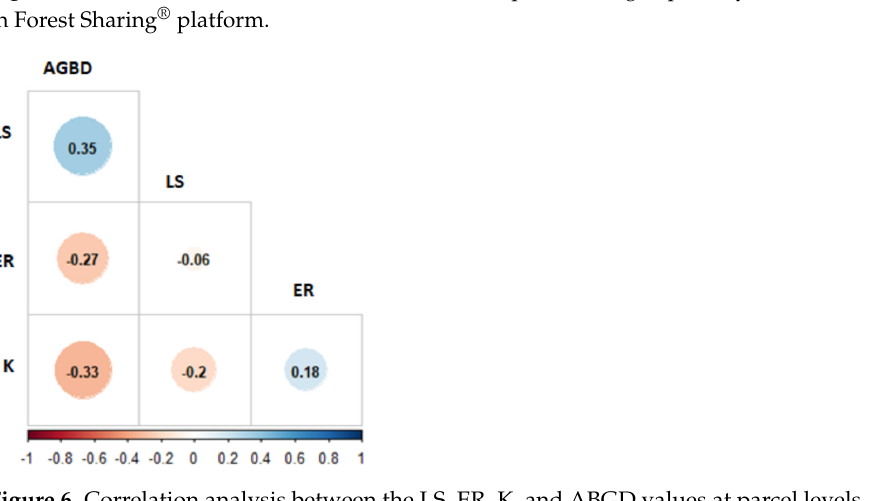
Figure 7. Distribution of accessibility by first SFM attitude for parcels in Forest Sharing ® platform. 4. Discussion The Italian forest scenario, based on the data collected via the Forest Sharing ® plat- form, is confirmed to be very fragmented, as demonstrated by other studies on European forests [6,8,11]. Moreover, the properties are small, with a mean forest area per user of 8.2 ha, which is less than European average (12.7 ha) [13,16], and are often abandoned. This dynamic can leads to a degradation of forest resources [14,19,51,52].